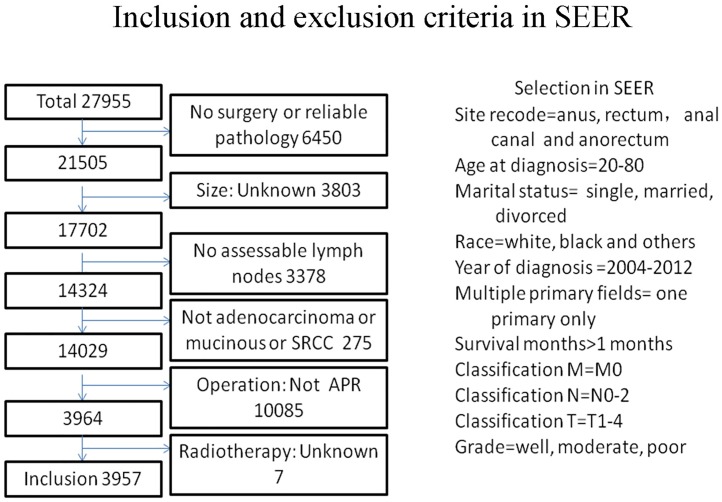
The inclusion and exclusion criteria in seer.